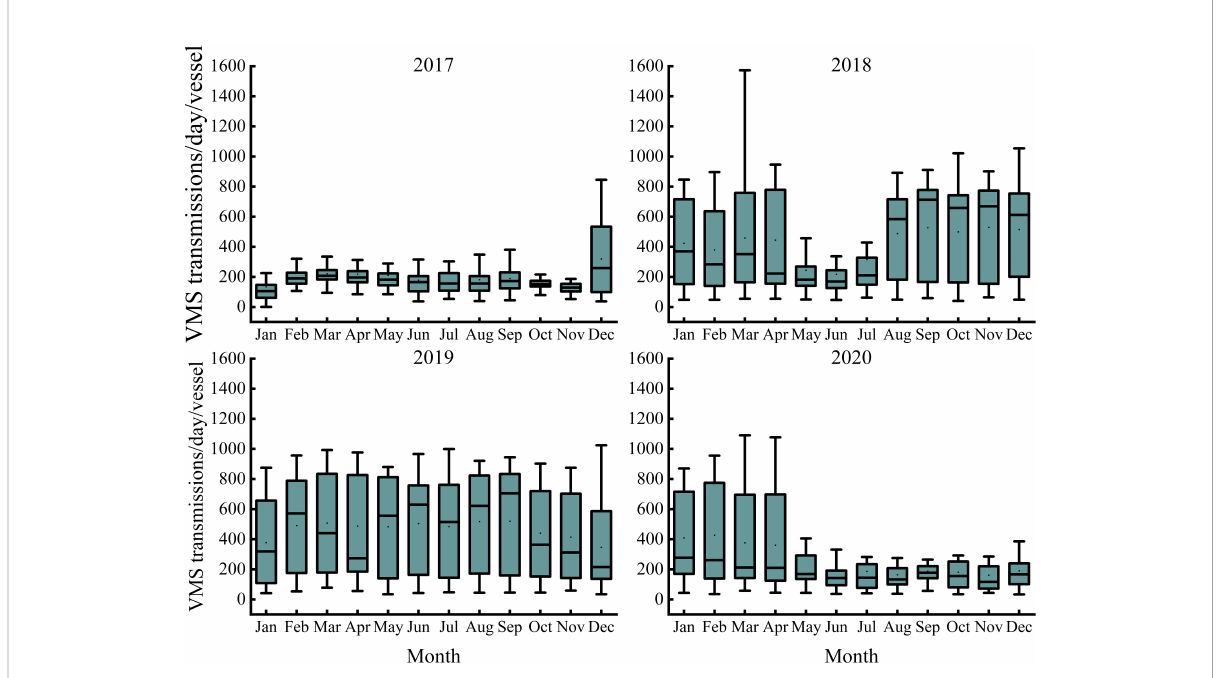
FIGURE 4 Average monthly numbers of Beidou vessel monitoring system transmissions per vessel per day in 2018.